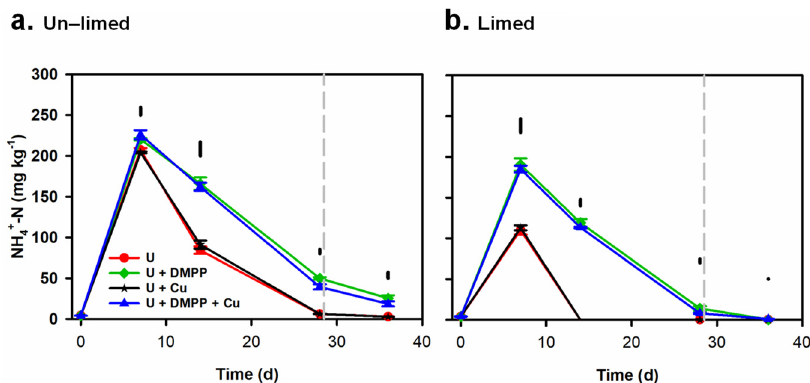
Figure 3. Effects of urea, DMPP, and Cu on soil NH 4+ –N concentrations in the ( a ) un-limed treatment and ( b ) limed treatment. The soil water was maintained at 55% WHC for the first 28 d then increased to 90% WHC for the remainder of the experimental period (as indicated by the grey broken vertical line). Data are the means of four replicates ± SE. The single vertical bars indicate significant differences among treatments (LSD 0.05 ).